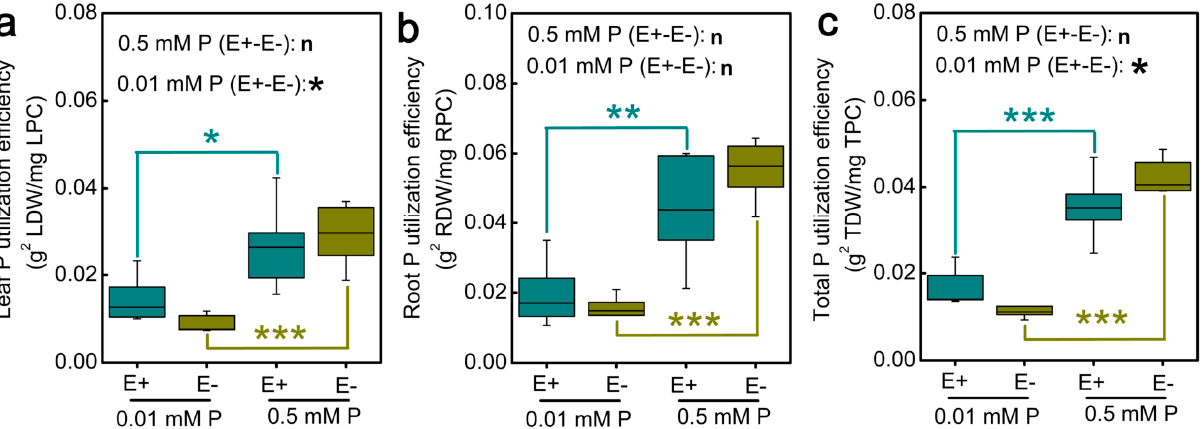
Figure 11. Phosphorus utilization efficiency of leaves ( a ), roots ( b ), and total ( c ) in E+ and E − Achnatherum inebrians at different P concentration. *, ** and *** showed differences at p < 0.05, p < 0.01, and p < 0.001, respectively.